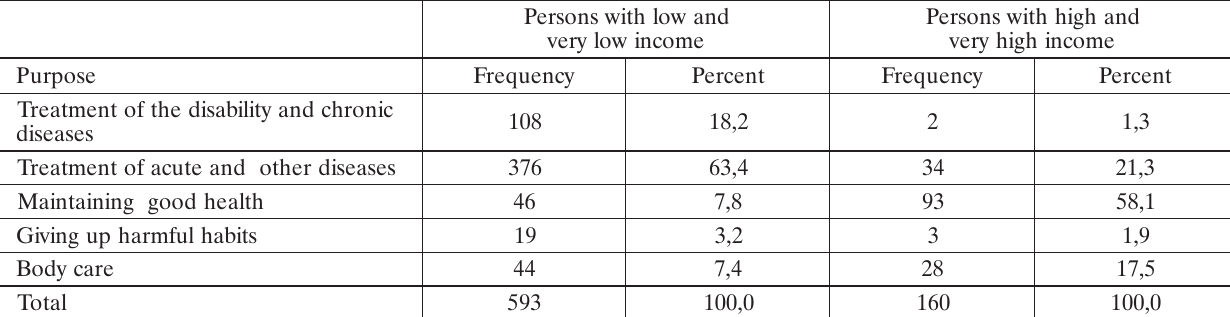
Table 4. Distribution of consumers according to their income and purpose of purchased pharmaceuticals